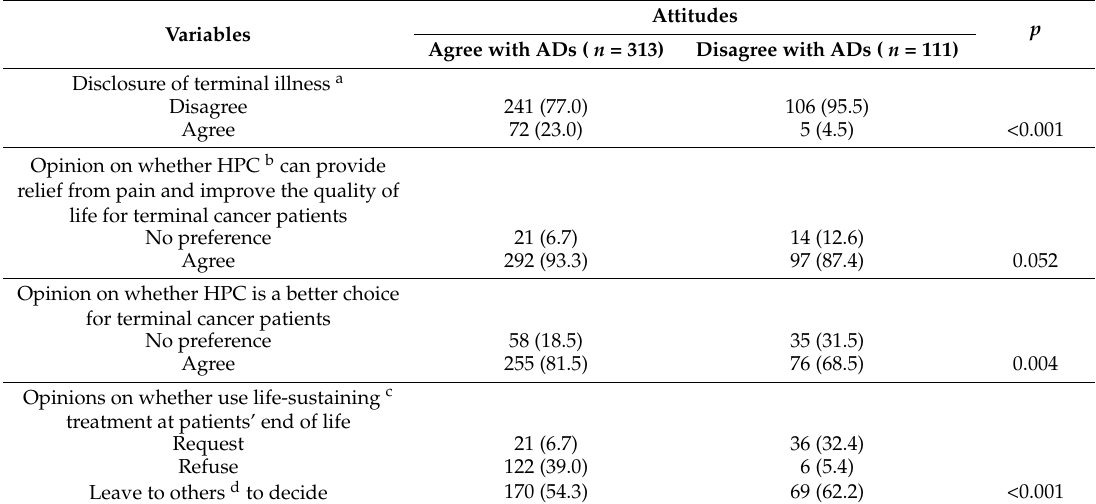
Table 4. Opinions on end-of-life decisions associated with participants’ attitudes toward